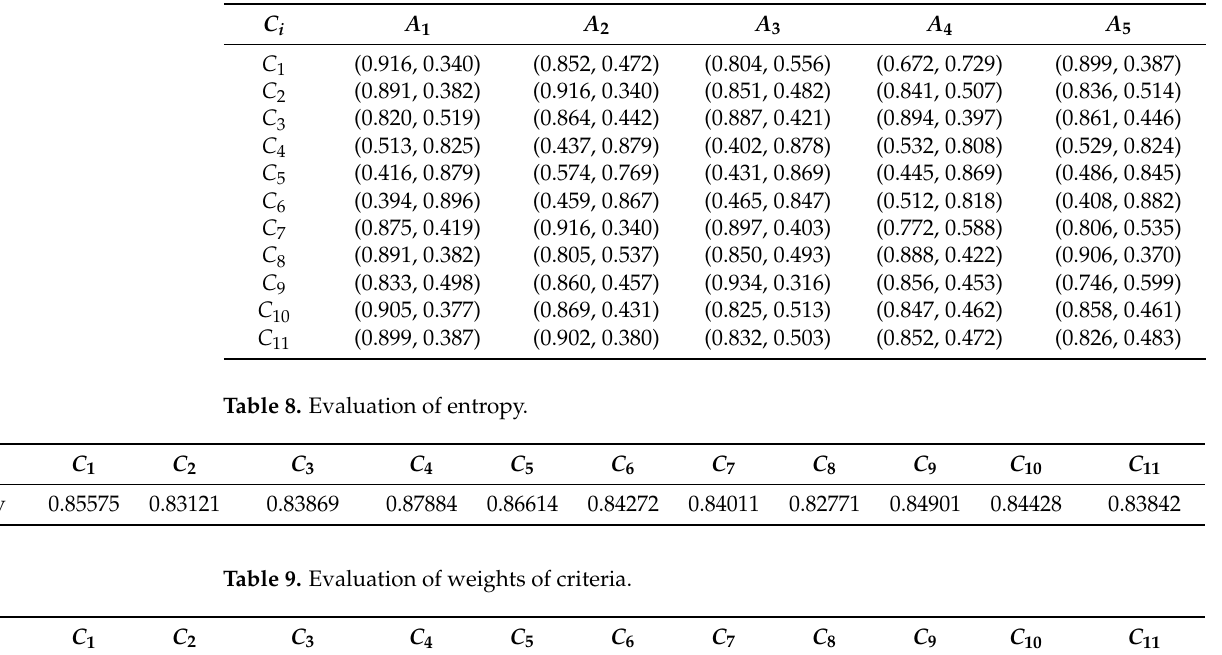
Table 7. Normalized aggregated Pythagorean fuzzy decision matrix.